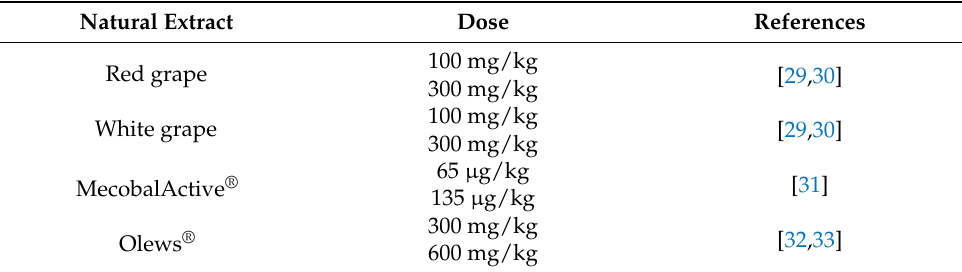
Table 1. Food supplements and concentrations used for the in vivo study.